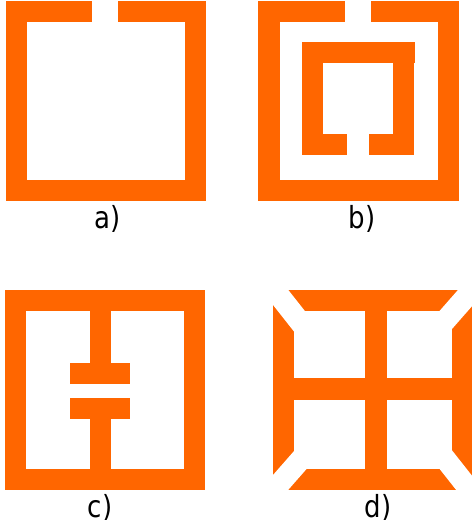
Figure 7. Some basic forms of split ring resonators with square unit